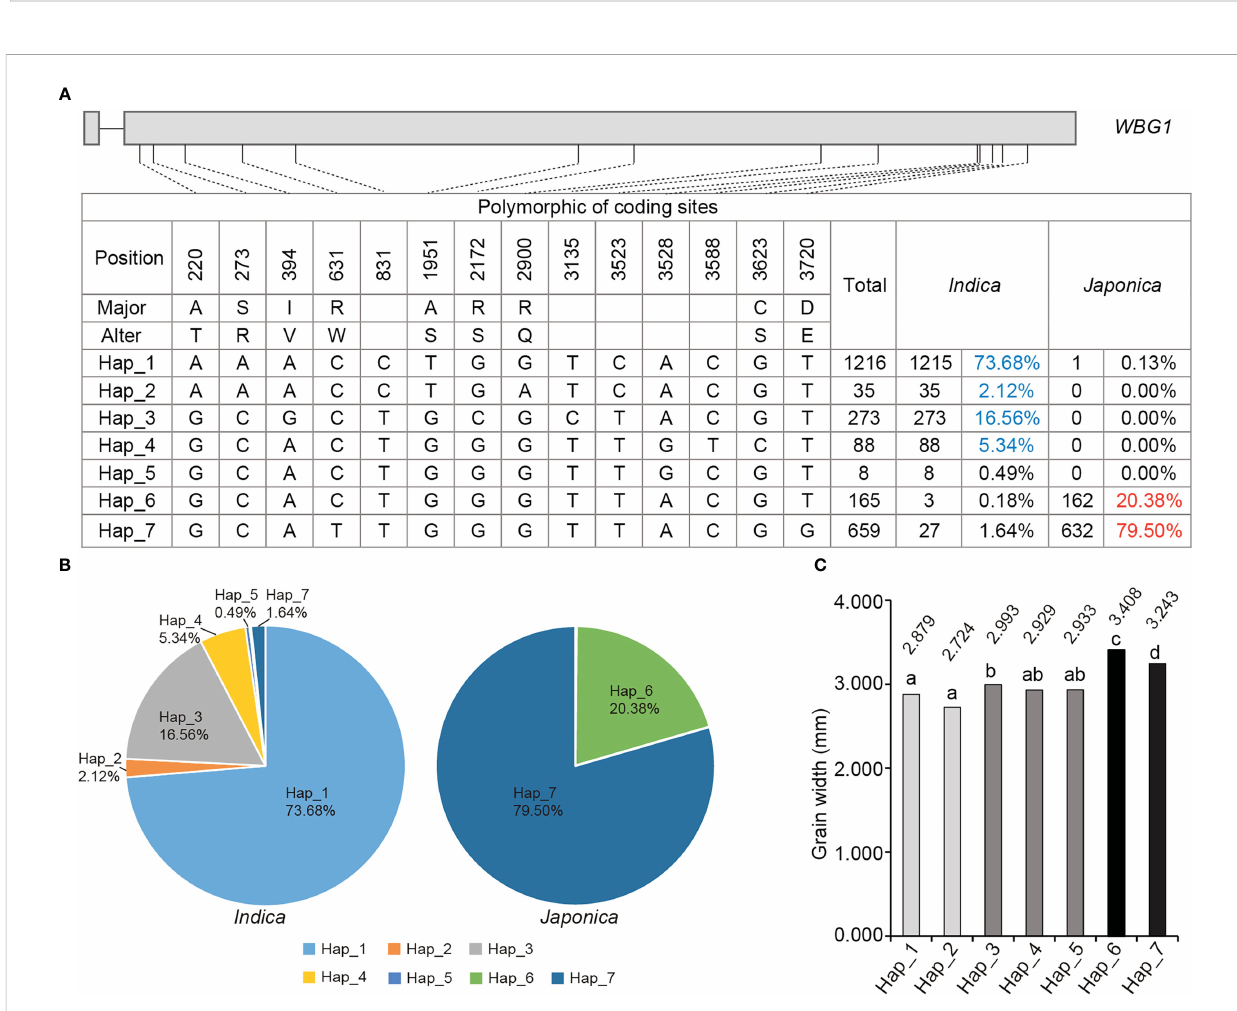
FIGURE 7 Haplotype analysis of WBG1 and haplotype association with rice grain width. (A) Polymorphic nucleotides in the WBG1 encoding region in indica and japonica cultivars. (B) Distribution of the proportion of seven haplotypes (Hap_1 to Hap_7) in indica (left) and japonica (right) cultivars. (C) Grain width statistics of the seven haplotypes. a – d indicate signi fi cant differences by Tukey ’ s t -tests ( p <